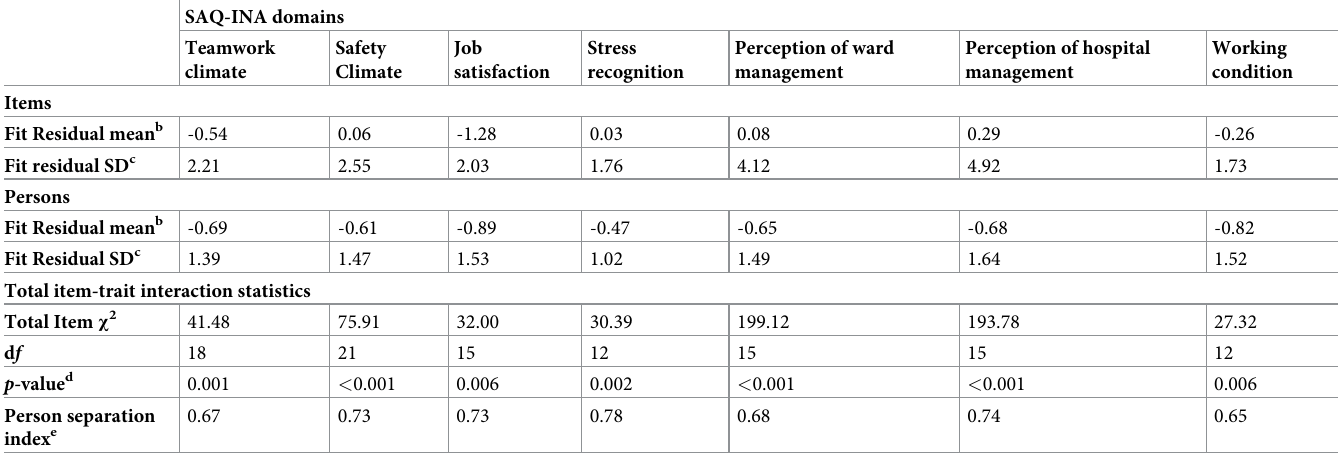
Table 2. Overall model fit for the SAQ-INA domains a